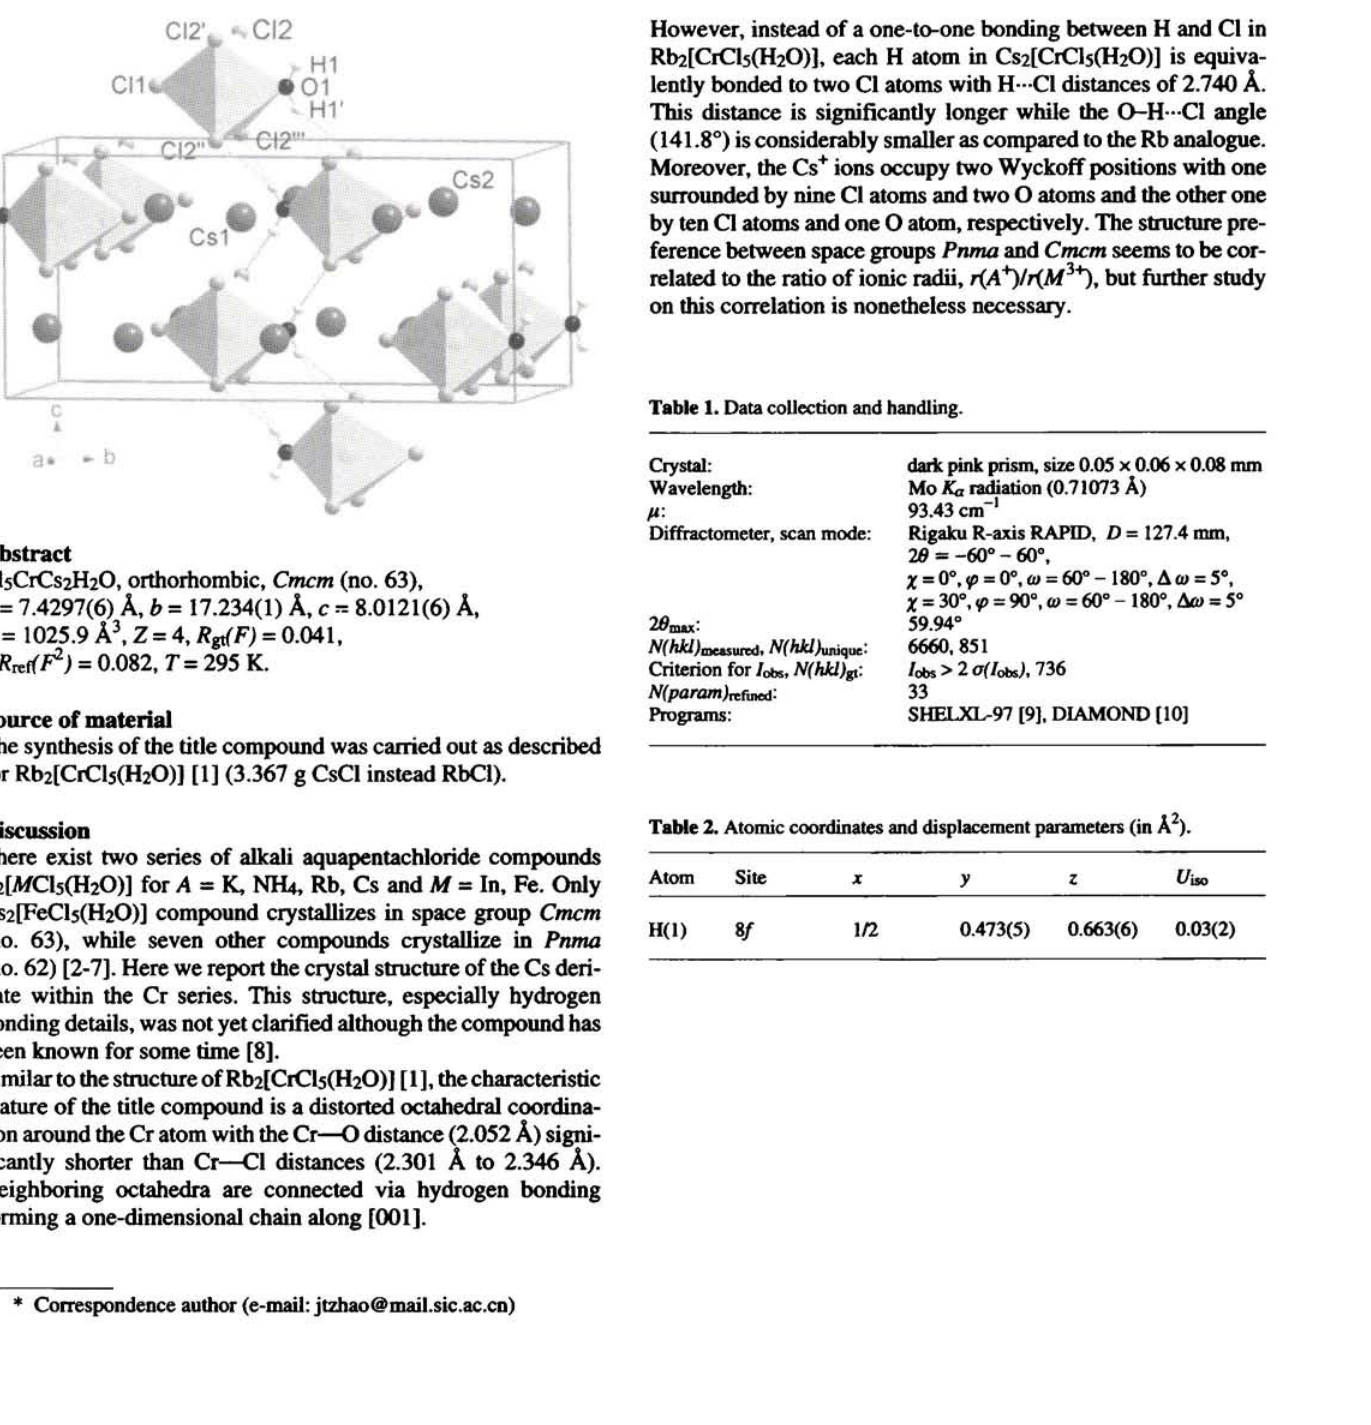
Table 2. Atomic coordinates and displacement parameters (in Â 2